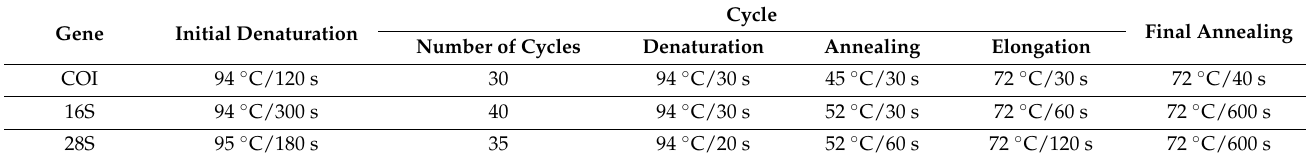
Table 2. PCR conditions for amplification of gene fragments used in this